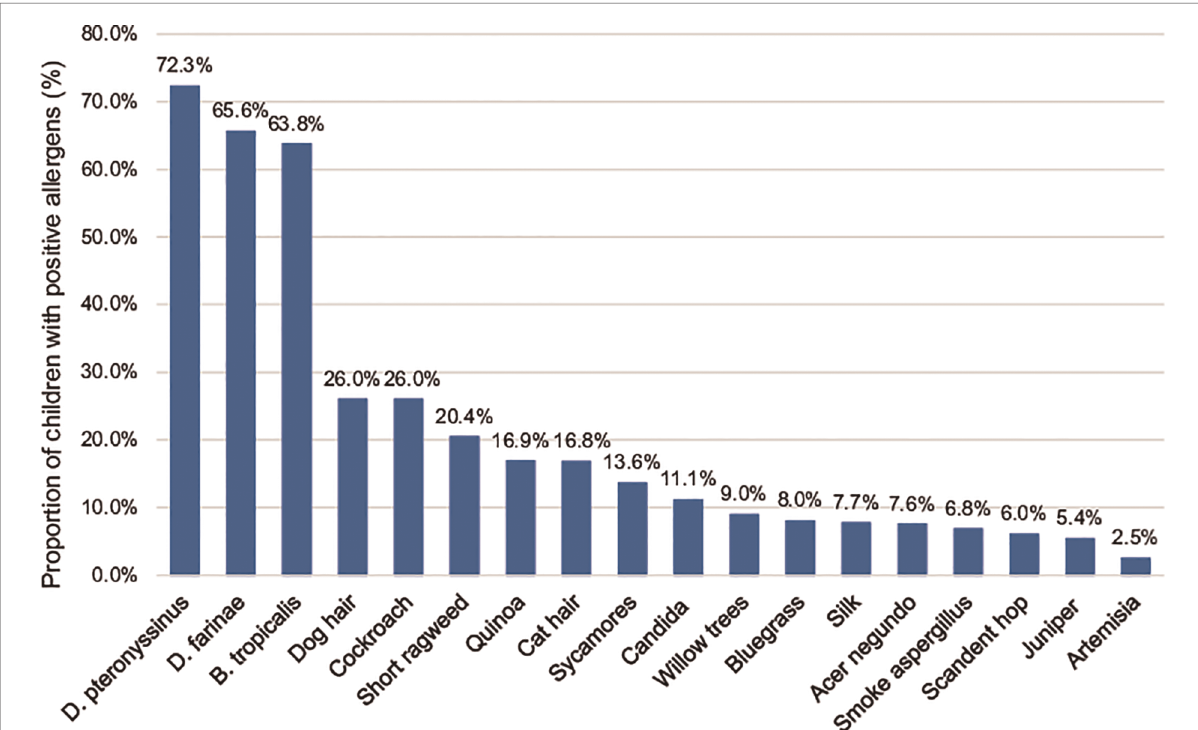
FIGURE 1 Distribution of inhaled allergens in 2,316 children with AR. The abscissa represents different inhaled allergens, and the ordinate exhibits their distributions in the AR